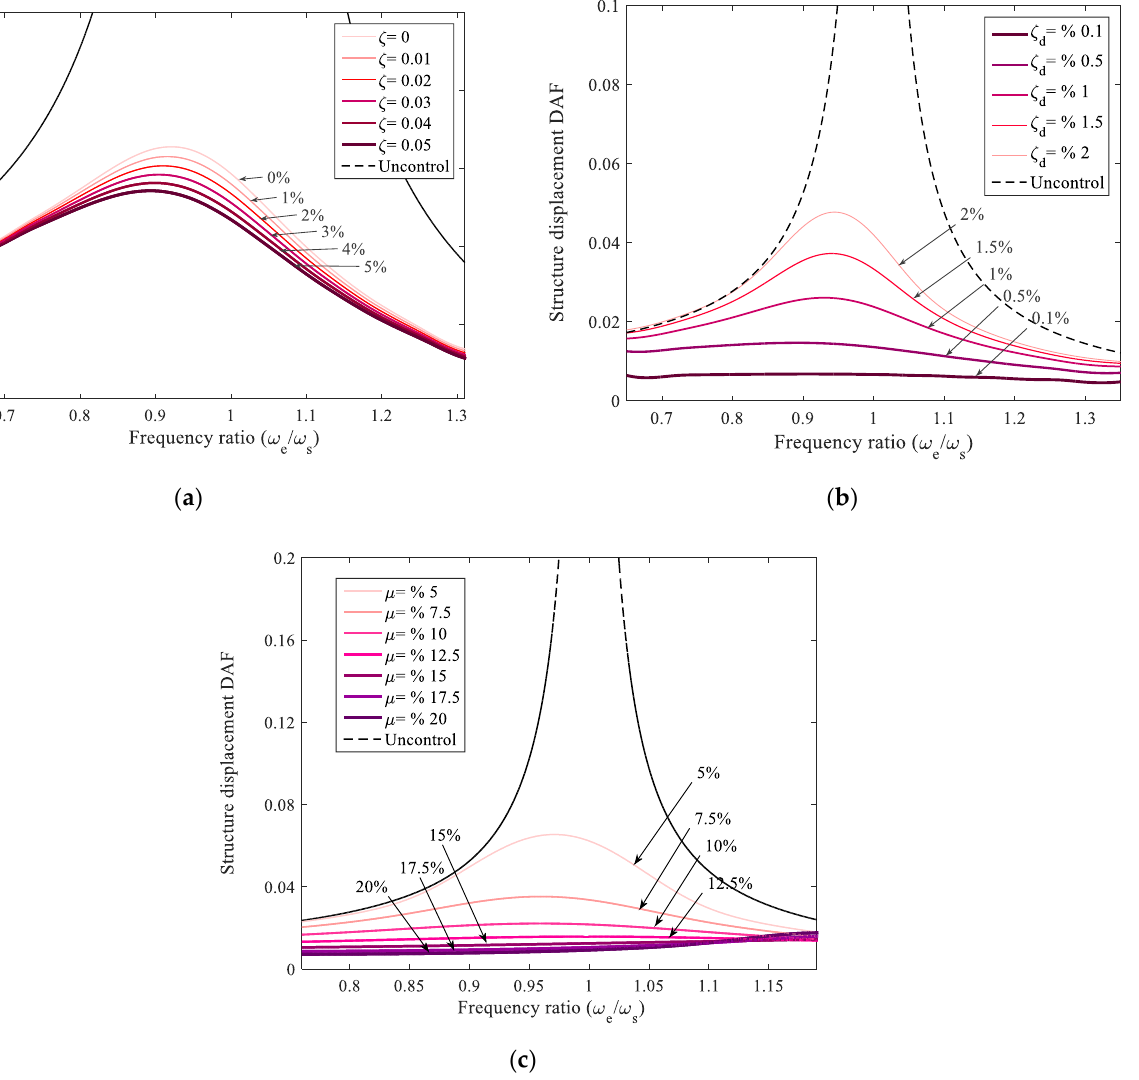
Figure 9. Damping properties of the ATMID based on: ( a ) inherent structural damping coefficient, ( b ) ATMID’s damping coefficient, ( c ) ATMID’s mass ratio.